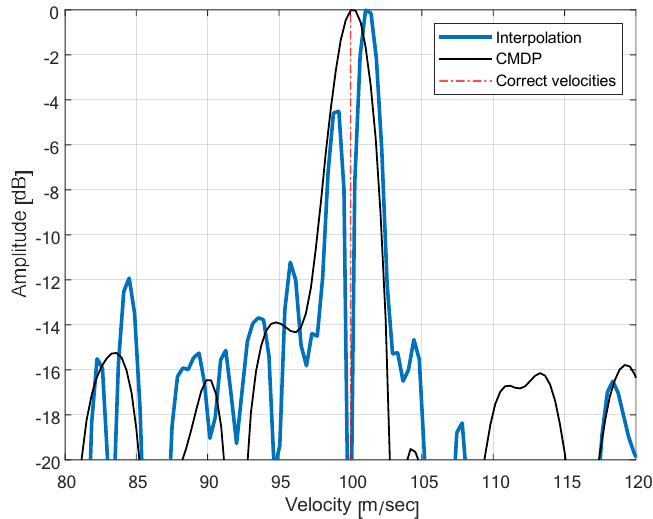
Figure 6. CMDP vs. interpolation for un-synchronized dwells.